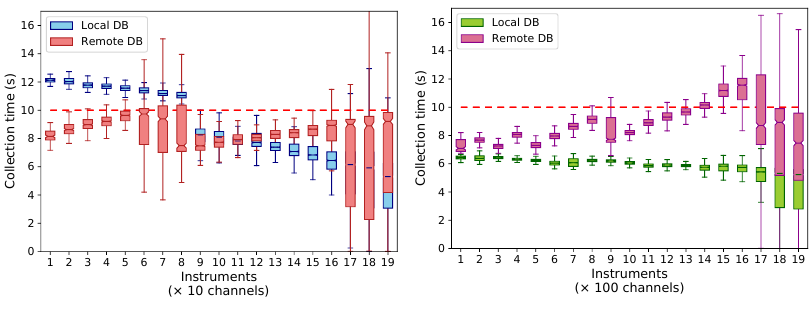
Table 1. Computational resources of each testing machine Figure 2. Instrument collection time versus number of monitored instruments in a single DAQBroker Resource High-power (HP) Low-power (LP) server on a LP machine ( left ) and a HP machine ( right